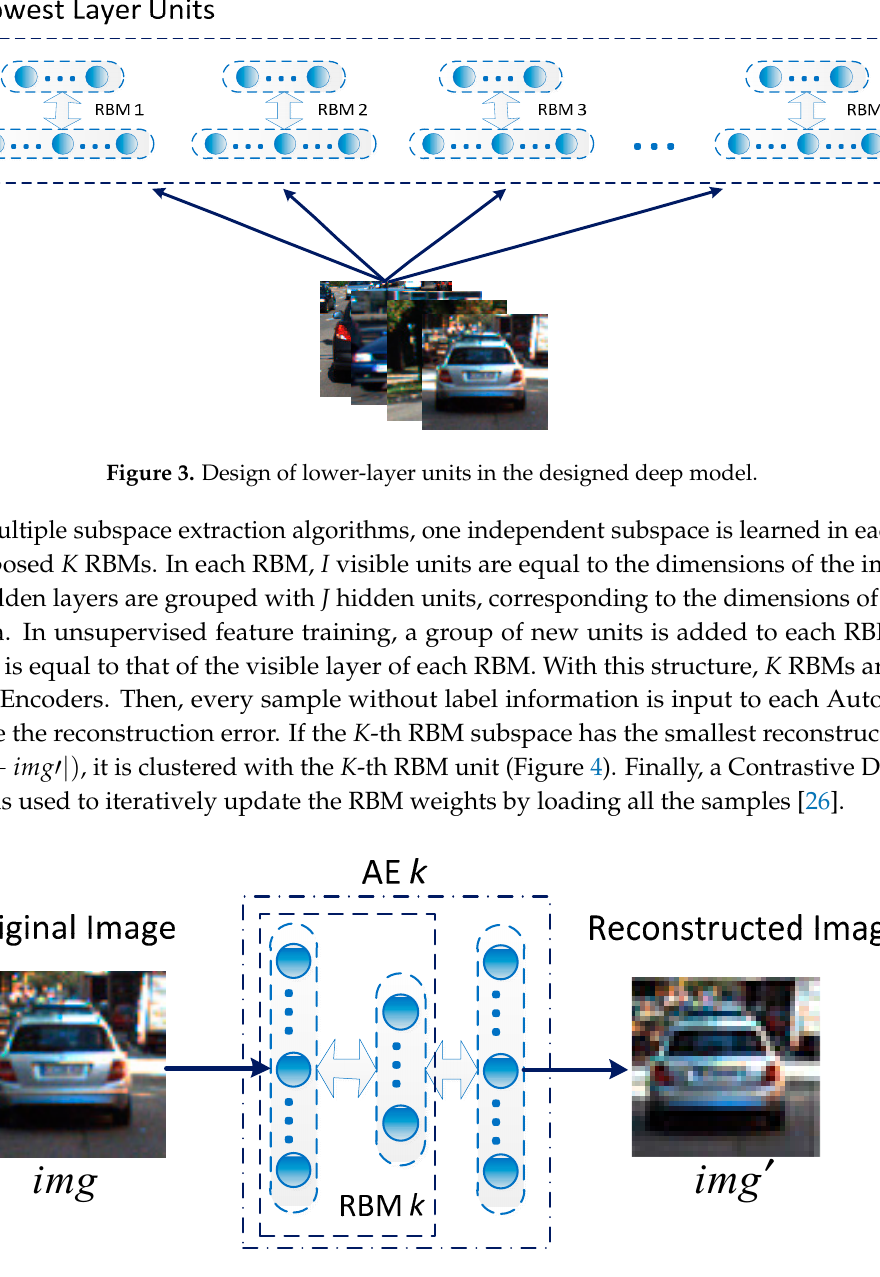
Figure 4. Feature subspace clustering and samples reconstruction based on auto-encoder.